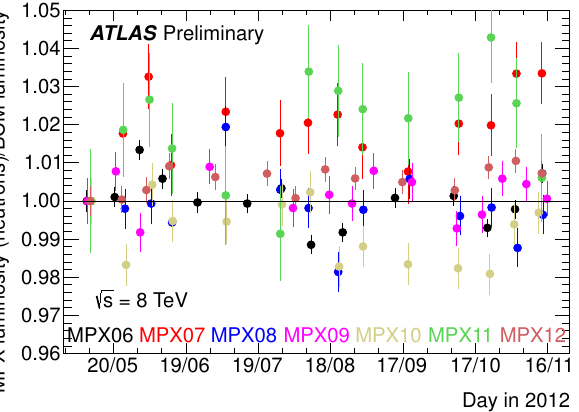
Figure 25. Fractional deviation in the luminosity (thermal neutron counting mode) reported by the MPX06 to MPX12 devices from the ATLAS reference luminosity (BCM) as a function of time in 2012. The ratio is shown for 14 time periods. For each device, the time periods are chosen to have the same number of frames. The data are scaled such that the value of the first bin is unity